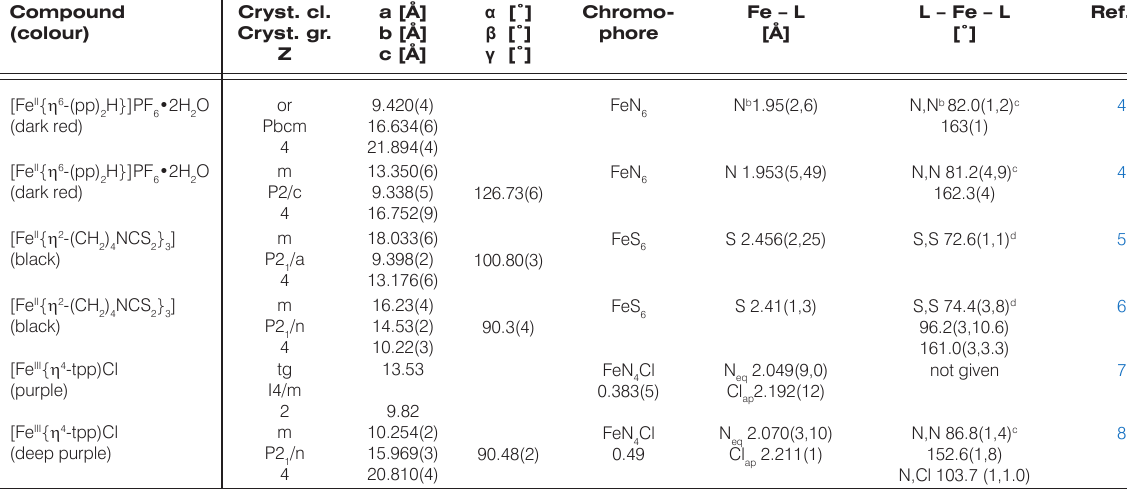
Table 1. Crystallographic and structural data for monomeric iron coordination compounds – distortion isomers a